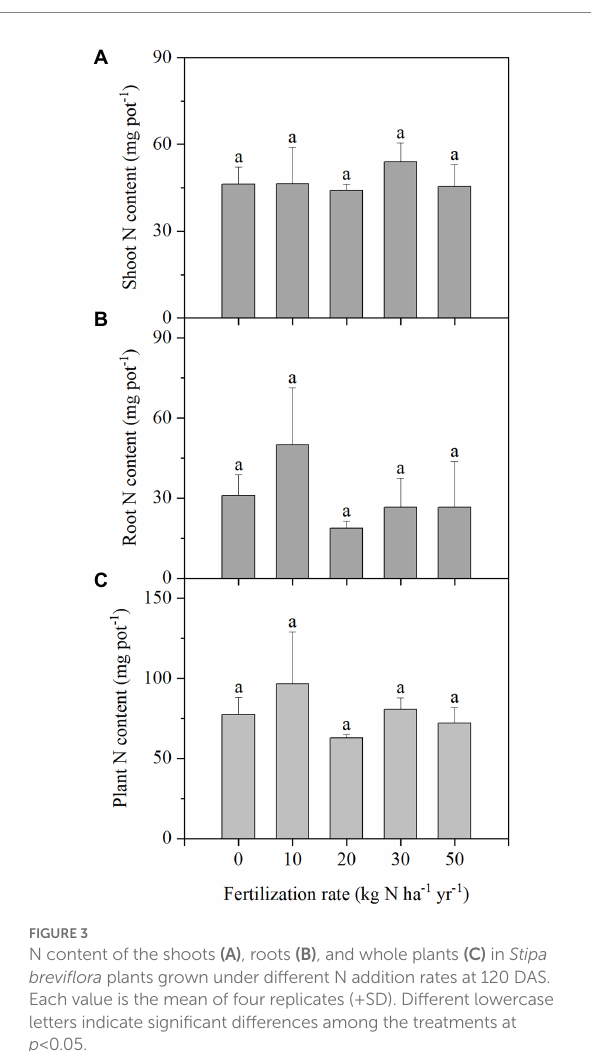
FIGURE 3 N content of the shoots (A) , roots (B) , and whole plants (C) in Stipa breviflora plants grown under different N addition rates at 120 DAS. Each value is the mean of four replicates (+SD). Different lowercase letters indicate significant differences among the treatments at p < 0.05.